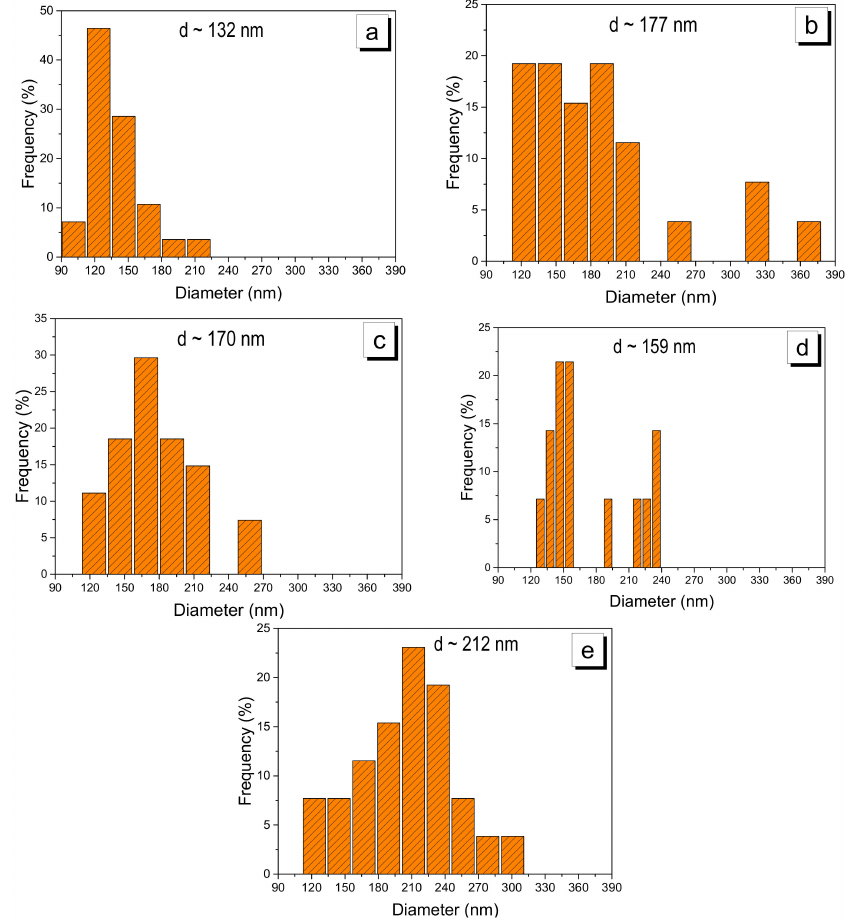
Figure 6. Histograms of nanofibers on the RVC support: ( a ) 15; ( b ) 30; ( c ) 60; ( d ) 90; and ( e ) 120